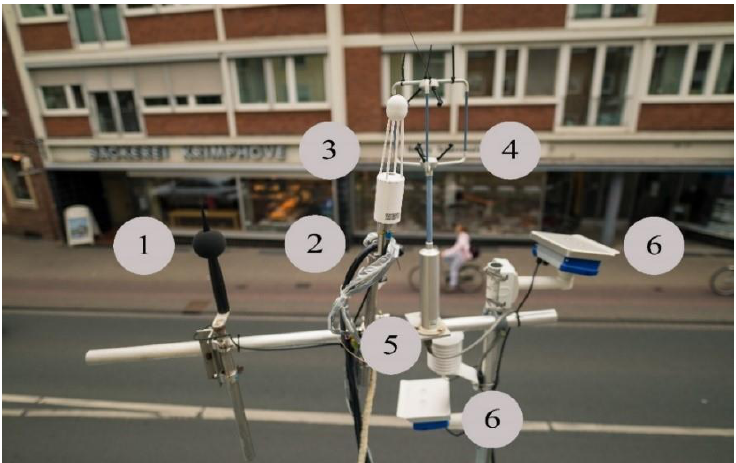
Figure 2. Setup on top of the container. A Class 1 microphone (1), air sample inlets for NH 3 , NO x , O 3 , and particles (2), a CO 2 -/H 2 O gas analyser (3), a sonic anemometer (4), a temperature and humidity sensor (5) and traffic cameras one in each direction (6).